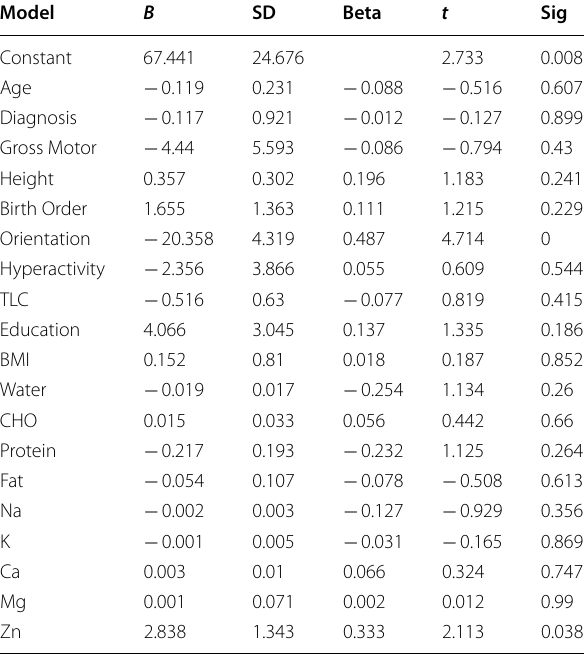
Table 7 Multiple analysis of the independent variables (age, diagnosis, gross motor, height, birth order, orientation, hyperactivity, TLC, education, BMI, water, CHO, protein, fat, Na, K, Ca, Mg, and Zn) on IQ